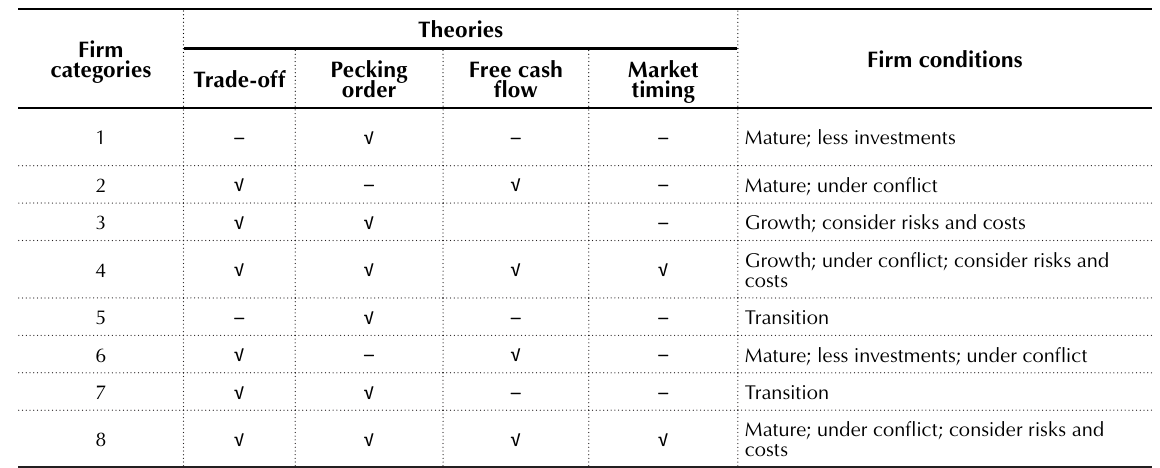
Table 5. Summary of findings for capital